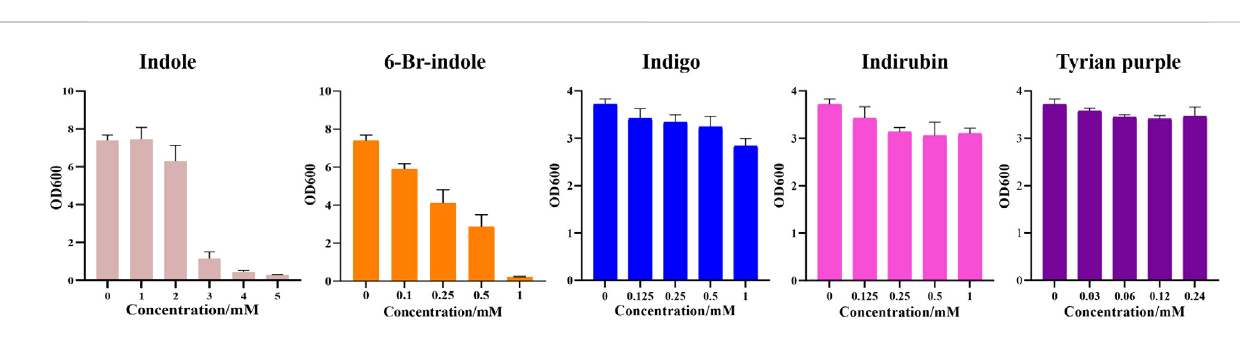
FIGURE 8 Proposed metabolic pathways contribute to the selectivity Tyrian purple-producing in E. coli .